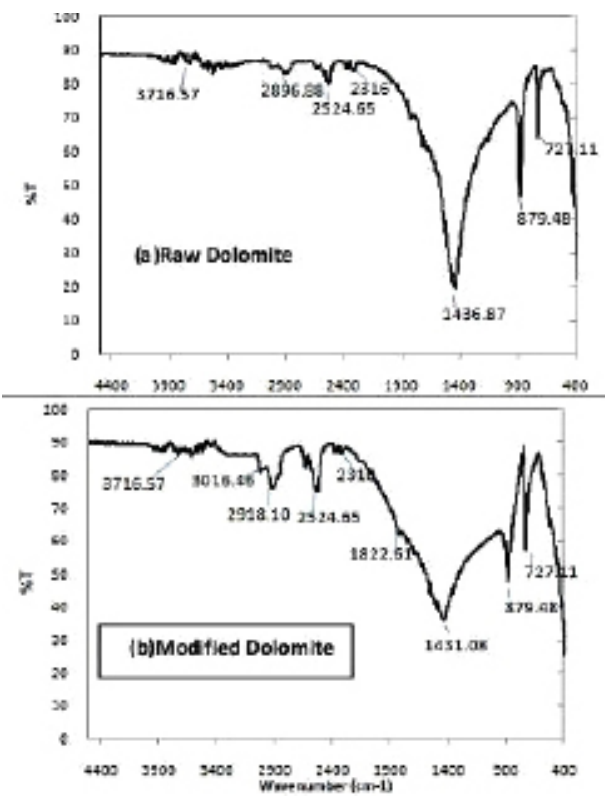
Fig. 2. FTIR spectrum of a) raw dolomite, b) modified